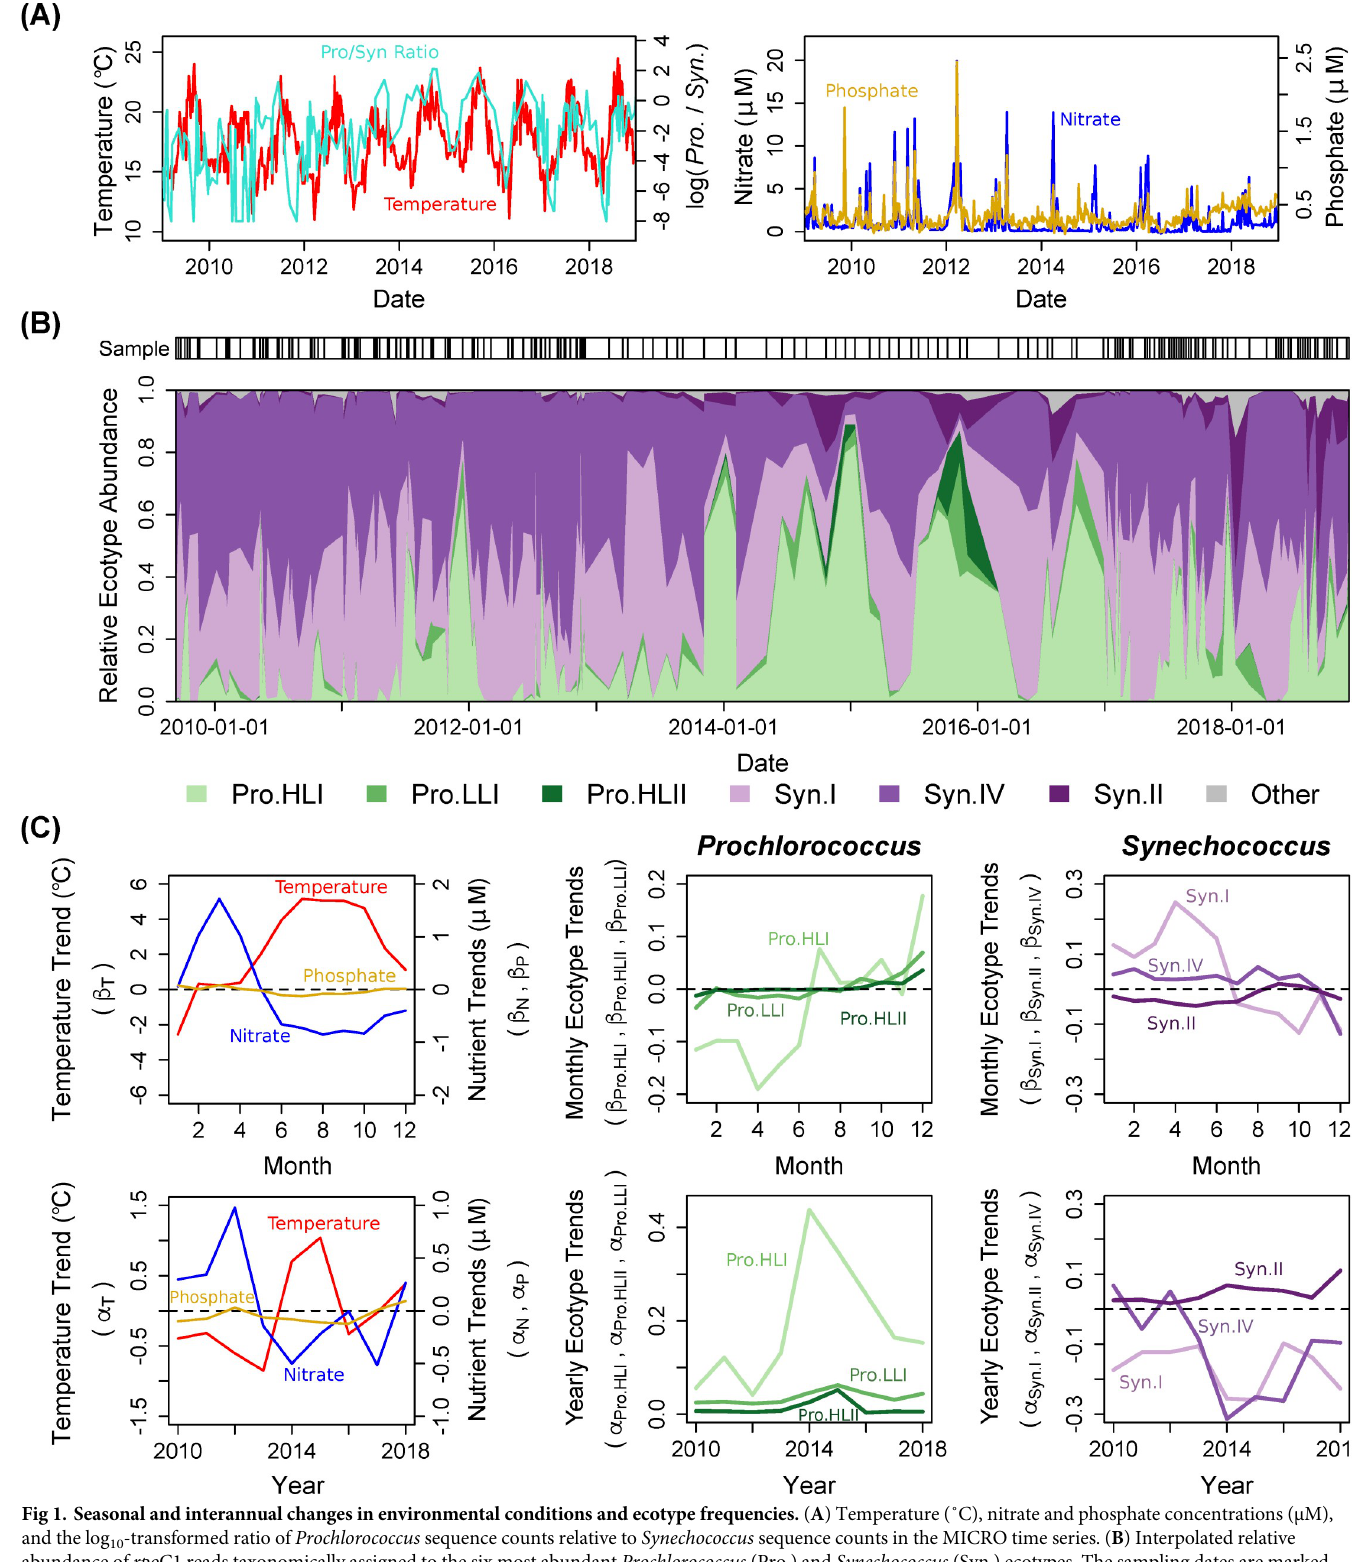
PLOS ONE | https://doi.org/10.1371/journal.pone.0238405 September 16,